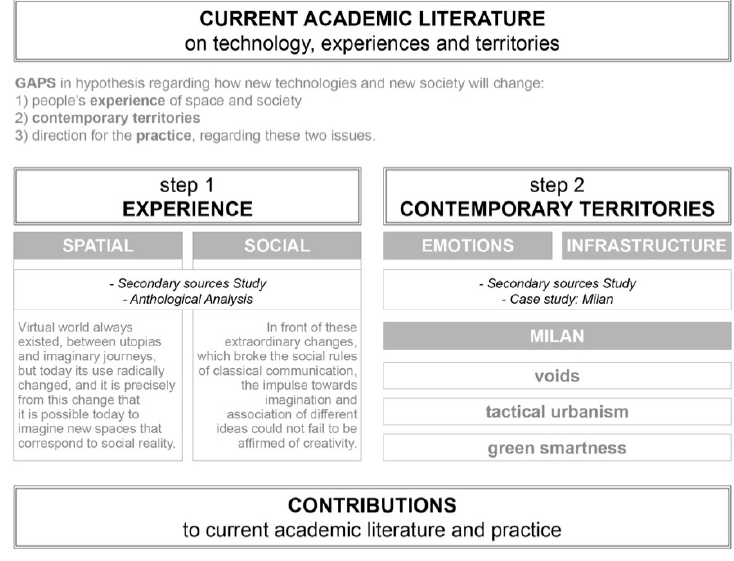
Figure 1. Scheme of the methodology used to develop the research.